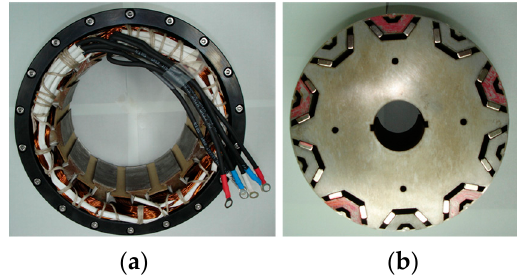
Table 4. The experimental instruments.